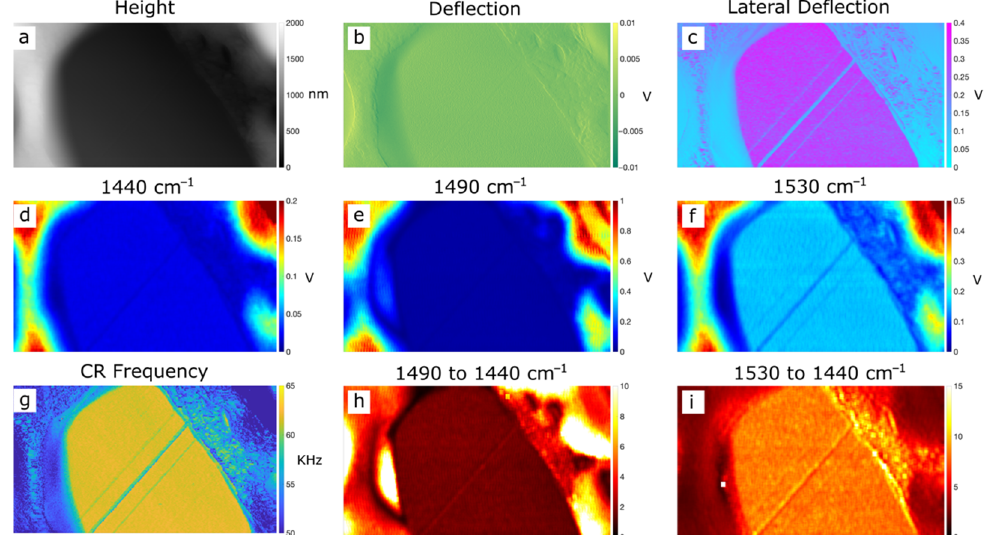
Figure A2. AFM-IR images of a microtomed section of PPB showing maps of: ( a ) height, ( b ) (vertical) deflection, ( c ) lateral deflection (friction), ( d ) IR intensity at 1440 cm − 1 (PBI), ( e ) IR intensity at 1490 cm − 1 (PEEK), ( f ) IR intensity at 1530 cm − 1 (PBI), ( g ) contact resonance (CR) frequency, and IR intensity ratio maps of ( h ) 1490 and ( i ) 1530 cm − 1 , relative to 1440 cm − 1 .